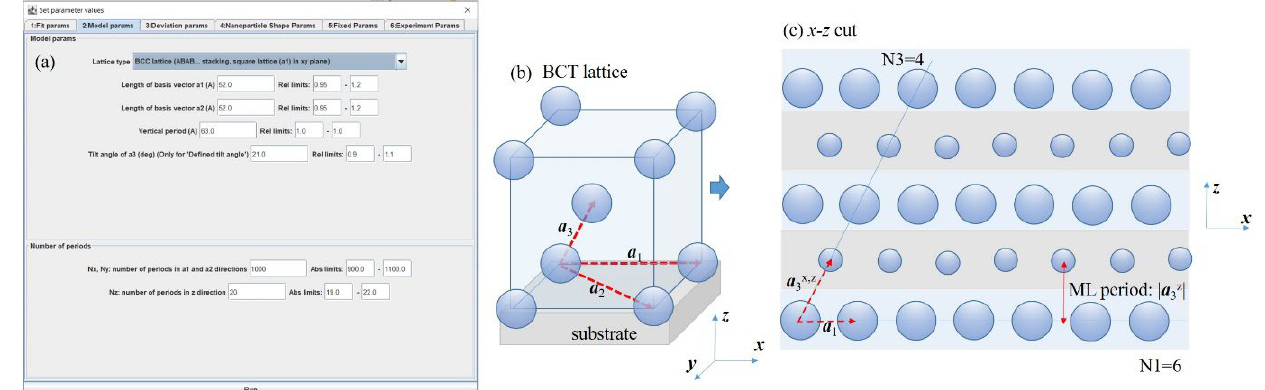
Figure 6. ( a ) Tab Model params with the corresponding parameters describing the lattice type and its main parameters. ( b ) Scheme of ordering in a body centered tetragonal (BCT) lattice defined by basis vectors a 1 – a 3 . ( c ) Cross-section of the 3D lattice of NPs having BCT unit cell with N 1 = 6 and N 3 = 4 periods along basis vectors a 1 and a 3 , respectively.